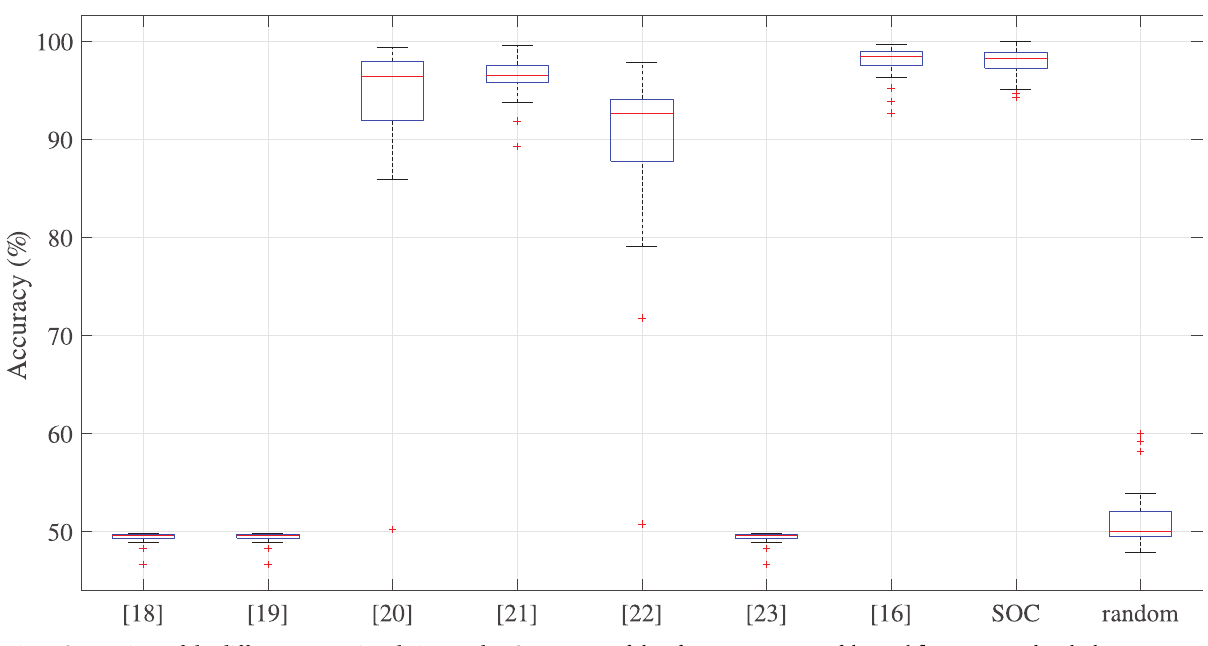
Fig 9. Comparison of the different processing chains results. Comparison of classification accuracies of the workflows presented in the literature (Table 1) with those of the near-optimal chain and a randomly-composed chain.